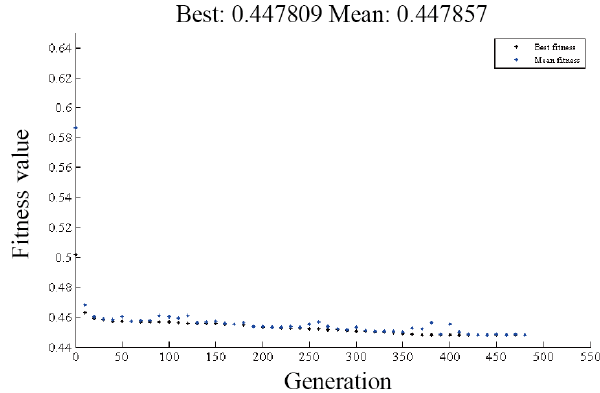
Figure 8. Optimization result of parameters using